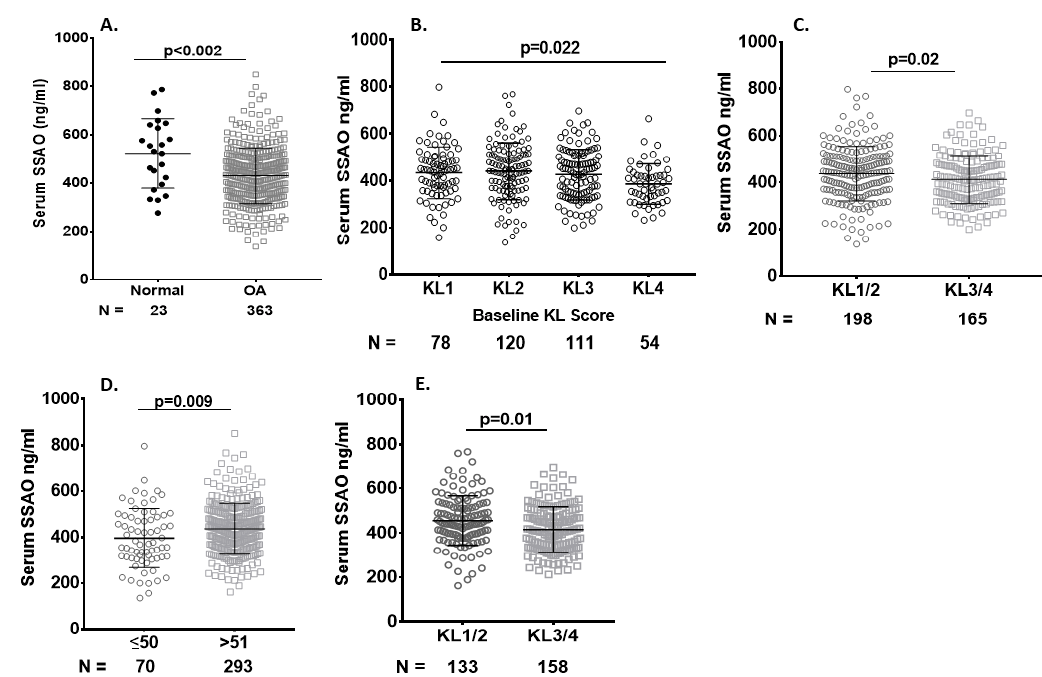
Figure 3. Serum levels of sVAP-1 are lower in OA patients than in controls. ( A ) Lower baseline serum sVAP-1 levels among patients with SKOA compared to normal. Baseline serum sVAP-1 levels ranged from 276.32 to 1105.39 ng / mL in non-OA controls and from 136.16 to 851.32.2 ng / mL in SKOA patients; ( B ) Comparison of serum sVAP-1 levels in radiographic KL (KL 1–4) groups of SKOA patients; ( C ) Lower serum sVAP-1 (412.6 + 102.7 ng / mL) levels in advanced radiographic (KL3 / 4) than early (KL1 / 2) 437.6 + 116.6 ng / mL SKOA patients; ( D ) Soluble VAP-1 levels were significantly higher in the age group > 51 years than in ≤ 50 year-old SKOA patients. Soluble VAP-1 levels ranged from 136.16 to 796.6 ng / mL in < 50 years and from 136.16 to 796.6 ng / mL in > 51-year-old SKOA patients; ( E ) Serum sVAP-1 levels were also lower in advanced (KL3 / 4) than early (KL1 / 2) compared with the general age group as shown above. N : number of individuals whose samples were tested. p values determined by nonparametric Mann–Whitney test or one-way analysis of variance (ANOVA). Bars in the graph shows the mean and standard deviation.